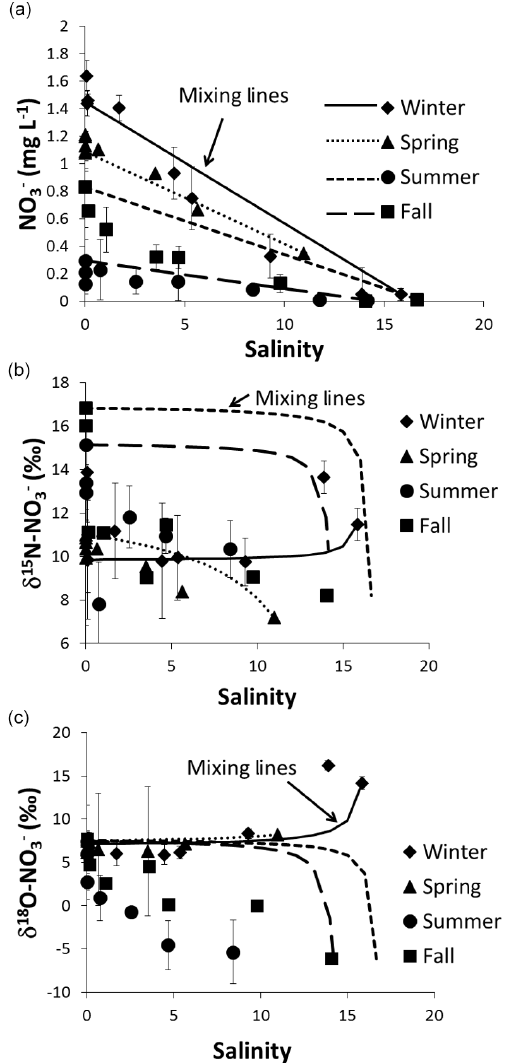
Figure 7. Comparison of salinity vs. (a) NO − , (b) δ 15 N-NO − , and 3 3 (c) δ 18 O-NO − . Mixing lines connect the mean NO − concentration 3 3 or isotope values at the lowest and highest salinity values. Error bars are standard errors of the mean. For (a) , N = 3 for all seasons; for (b) and (c) , N = 1 for winter, N = 3 for spring and fall, and N = 2 for summer. Mixing line equations for NO − concentrations and iso- 3 topes were obtained from Middelburg and Nieuwenhuize (2001). NO − data were obtained from the Maryland DNR and the Chesa- 3 peake Bay Program Data Hub, covering spring 2010 to spring 2011, the same dates as the NO − isotope 3